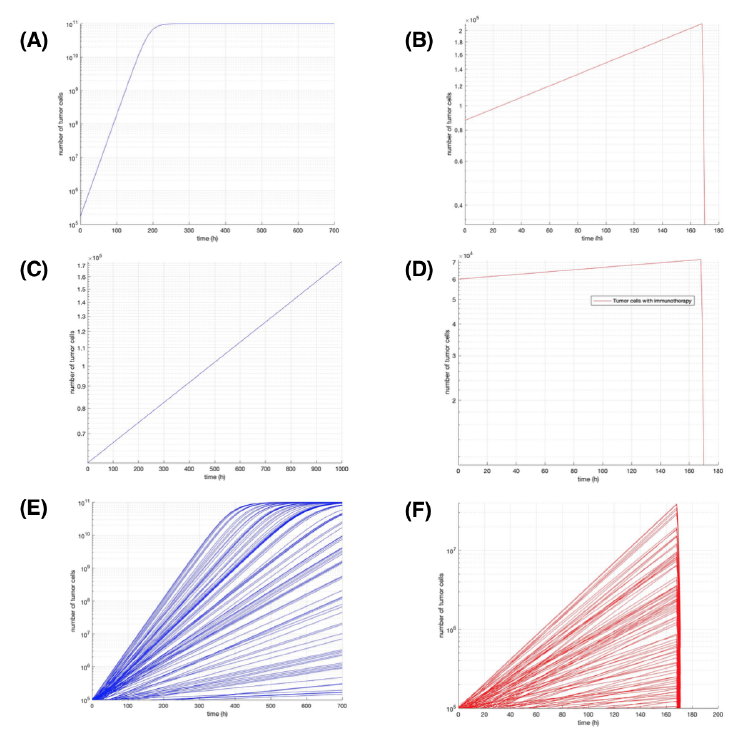
Figure 3. Hypothetical therapies results. They represent the tumor growth with the immunotherapy treatment and blue curves represent the growth of tumor cells without treatment. In Figure 3 all simulations implement a therapy using 10 9 DCs infused every 72 h by 3 weeks using 100 different initial conditions. Subfigures ( A , C ) shows the result of one simulation without treatment; likewise, subfigures ( B , D ) shows also the result of one simulation but with immunotherapy treatment. Ad- ditionally, subfigures ( E , F ) show the results but for 100 different simulations showing the same behavior as